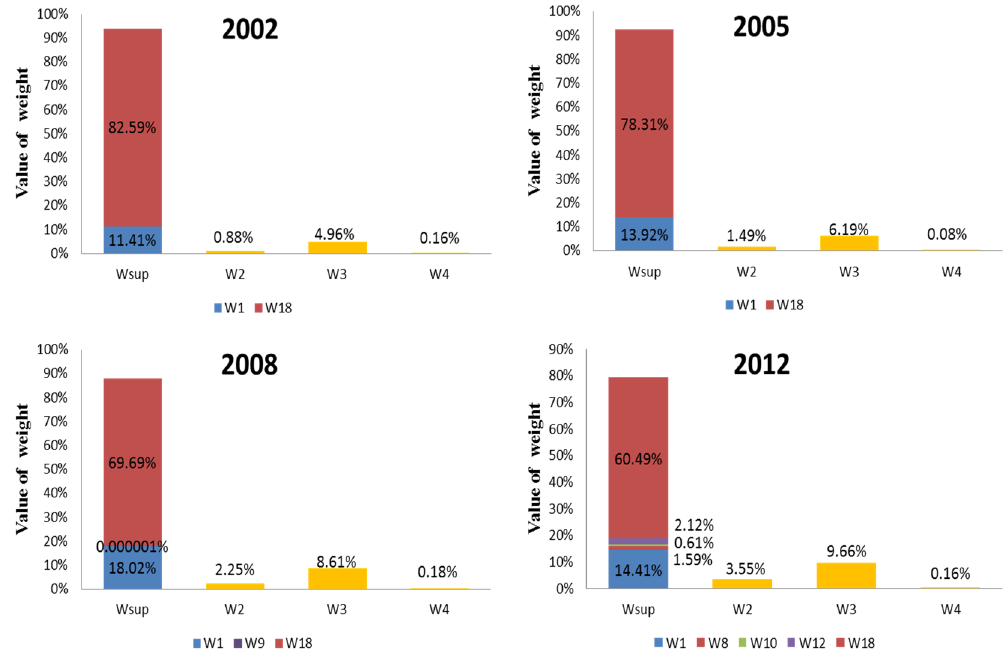
Figure 6. The weights of different nodes of China’s natural gas supply system from 2000 to 2012 based on a network model constructed on the NL. The first column, named W sup, indicates the weights of supply sources, including internal sources. Within the W sup column, the blue bar at the bottom, denoted as W 1, indicates the production sector. External sources are shown in other colors in the first column. They are denoted as W 8, W 9, W 10, W 12, and W 18, representing the weights of Australia, Indonesia, Malaysia, the Russian Federation, and other countries, respectively. However, the weights of other countries were too small to be displayed in this figure. The second, third, and forth column represent the weights of the refining, consumption, and reserve sectors are indicated by W 2, W 3, and W 4, respectively.